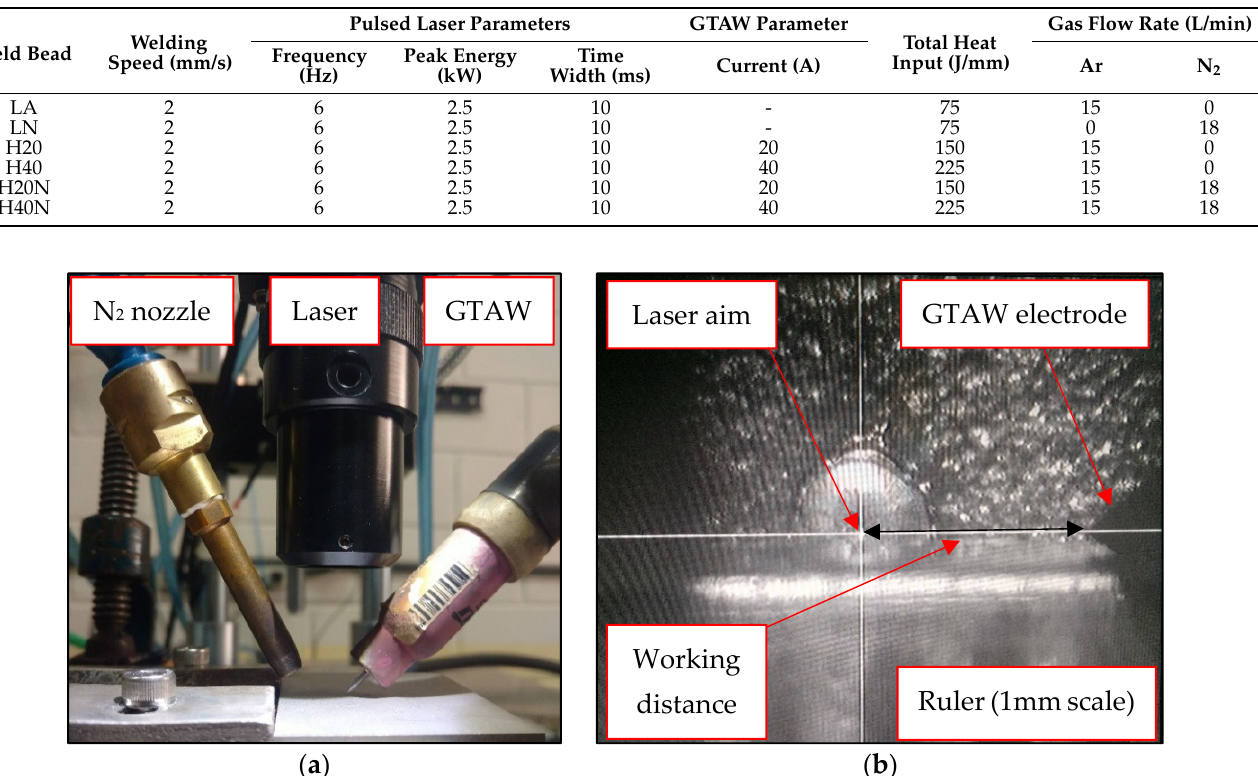
Figure 3. ( a ) Hybrid GTAW laser welding arrangement. ( b ) Laser camera view.